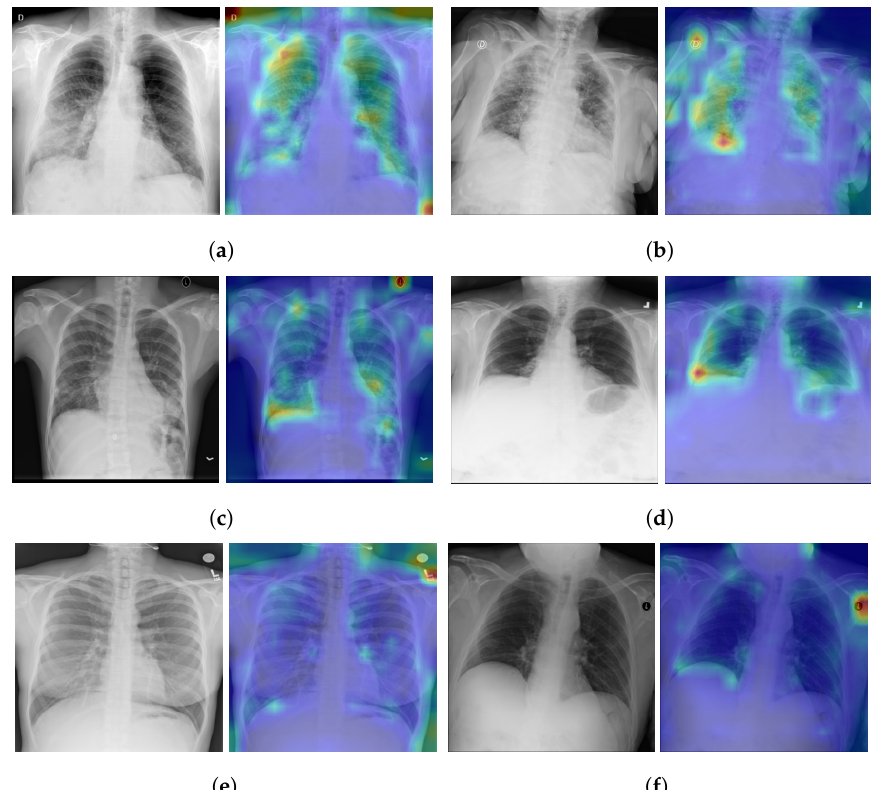
Figure 6. Explainabilty of TP and TN cases: ( a , b ) TP of COVID-19, ( c , d ) TP of Pneumonia, and ( e , f ) TN of Normal. The green and yellow/red colors highlight important areas detected by the ViT model (ViT-B32) on the CXR images by using the attention weights from transformer block.